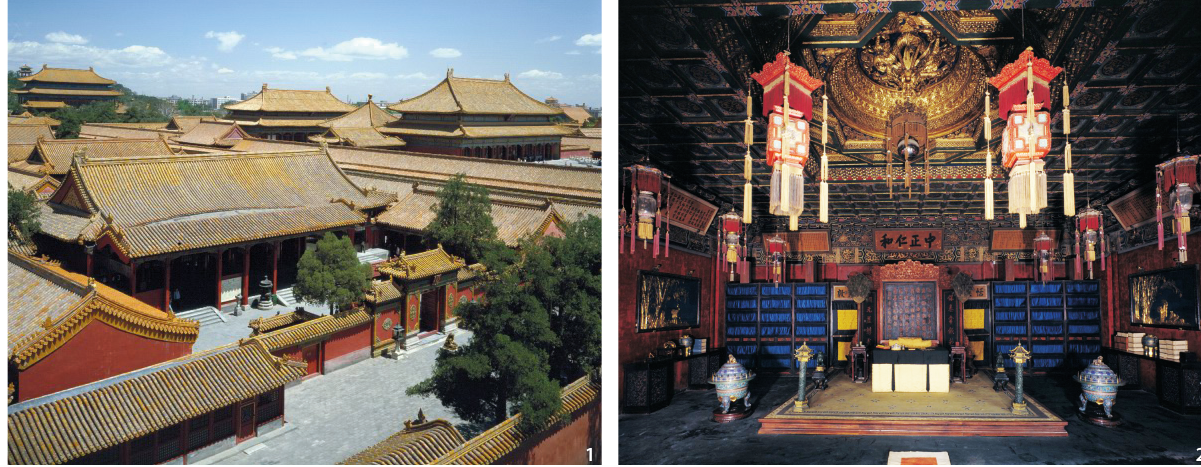
Figure 1 Bird’s-eye view of the Hall of Mental Cultivation Complex (Source: Hong Yang). Figure 2 The central bay of the front hall of the Hall of Mental Cultivation (Source: Hong